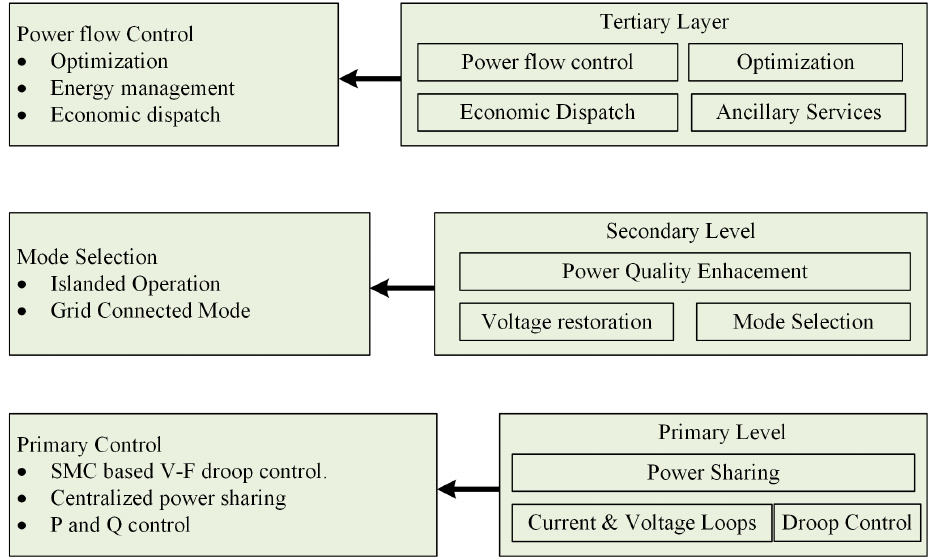
Figure 5. Hierarchical control